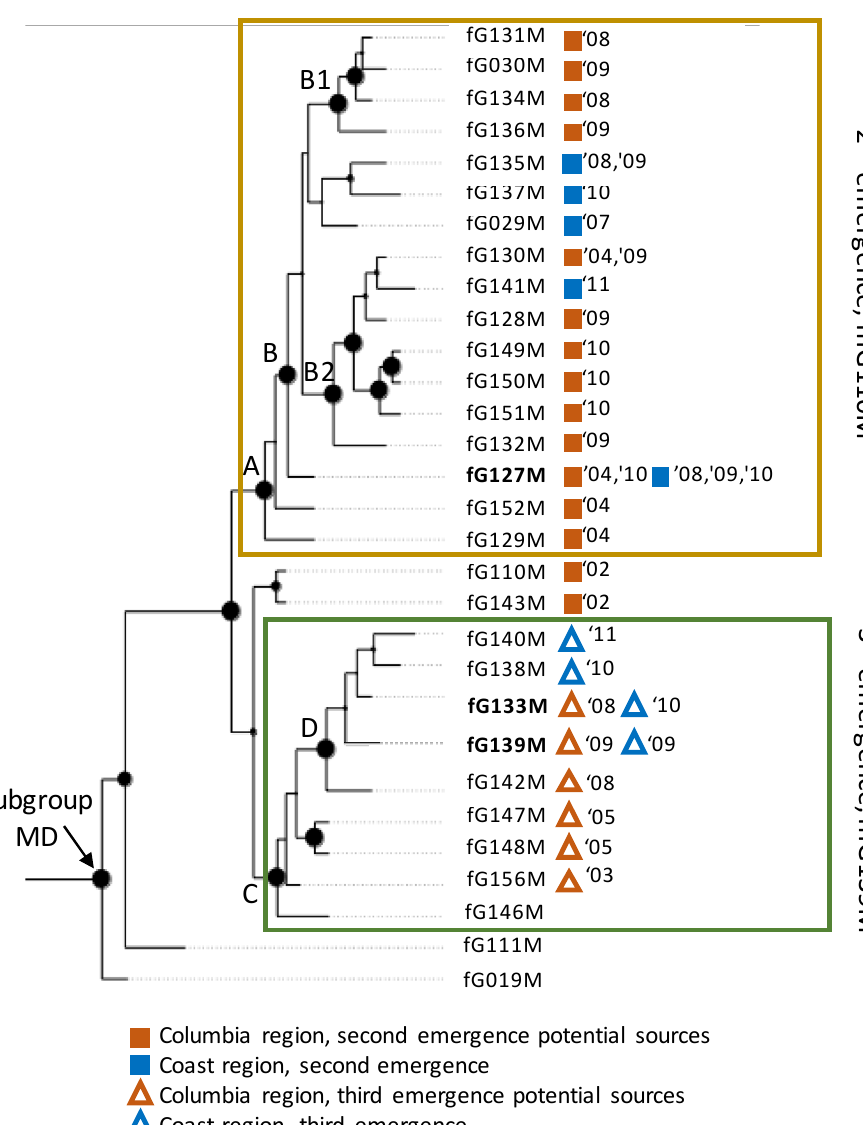
Figure 2. Phylogenetic tree of fullG sequence types from IHNV detections in North America—the subtree of MD subgroup fullG types is shown. Posterior probability (pp) statistics describing the likelihood that a given node existed in nature are shown as scaled circles. The fullG types originating from this study are indicated by a colored symbol (see legend), with year(s) of isolation. Letters A–D and B1, B2 indicate nodes mentioned in the text to describe the tree. The heterogeneous genotype fG129m/fG157M was not included in the analysis. FullG types found in both Columbia and coast regions are in bold text.